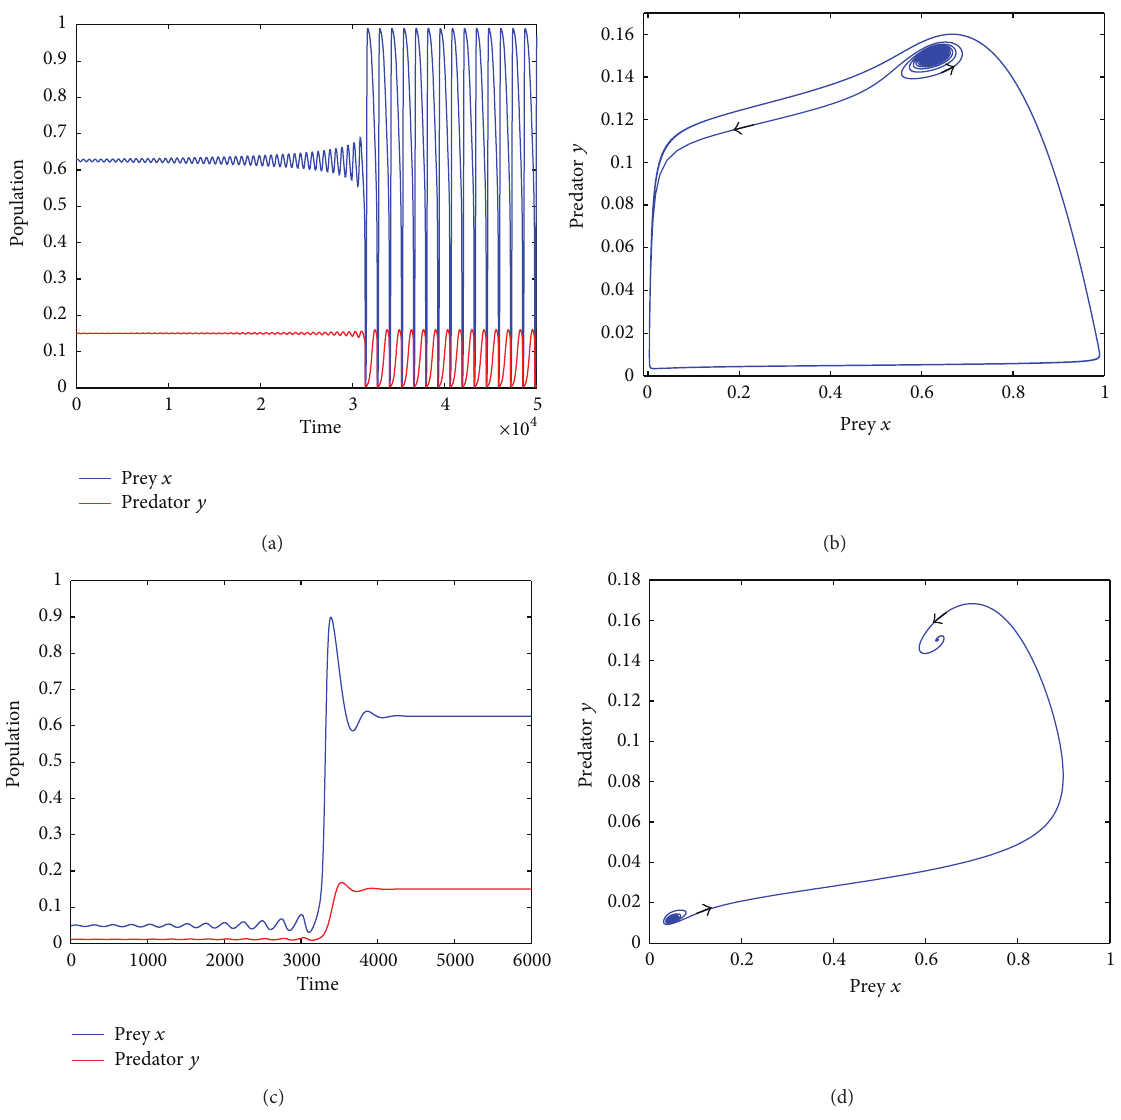
Figure 8: The trajectory graphs and phase portrait of system (7) without delay for (𝛼,𝛽) ∈ 𝐷 3 with 𝛼 = 0.01 and 𝛽 = 0.24 . (a)-(b) 𝛾 = ,𝛾 } . The initial value is (0.626, 0.15) . All of the three equilibria are unstable and there exists a stable periodic orbit. (c)-(d) 0.1 < min {𝛾 01 03 < 𝛾 = 0.3 < 𝛾 (0.049, 0.0116) . The positive equilibria 𝐸 ∗ 𝛾 03 01 . The initial value is